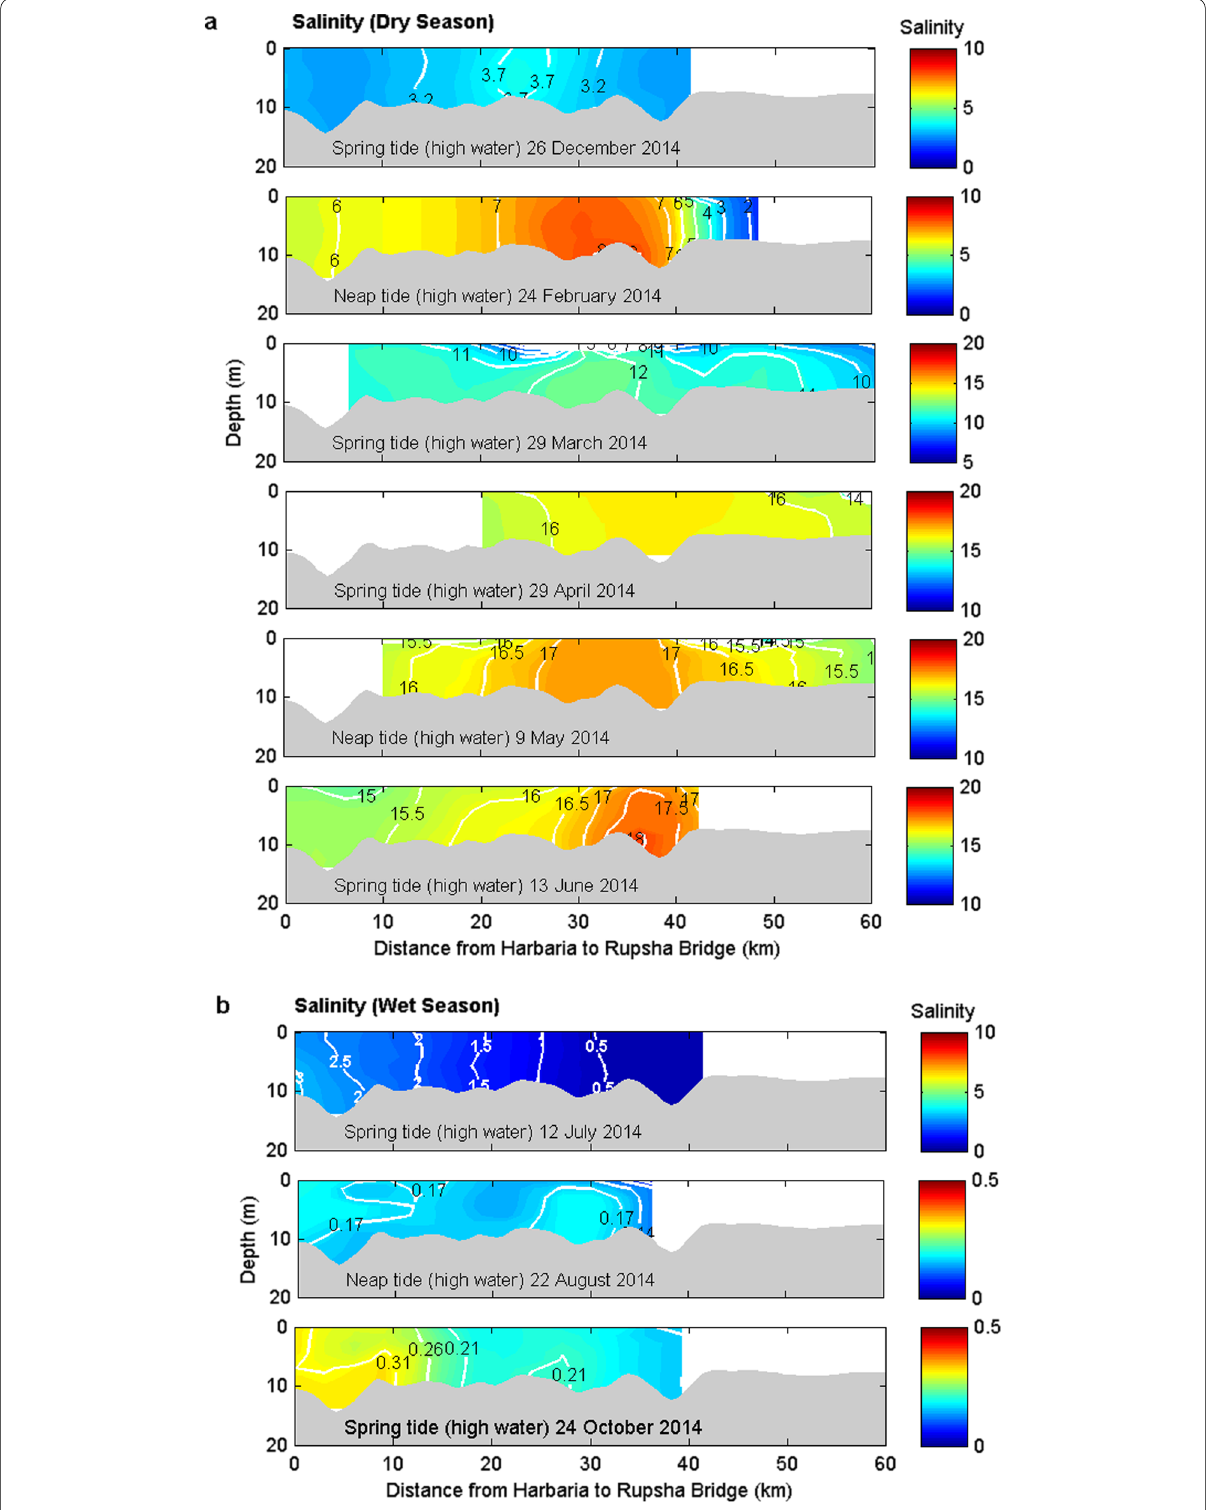
Fig. 5 Vertical salinity distribution at high water in the Pasur River estuary during spring and neap tides in the dry and wet seasons. Salinity maximum zone (salt plug area) is denoted as SP (25 ~ 45 km) and downstream of salt plug area is denoted as DSP (< 20